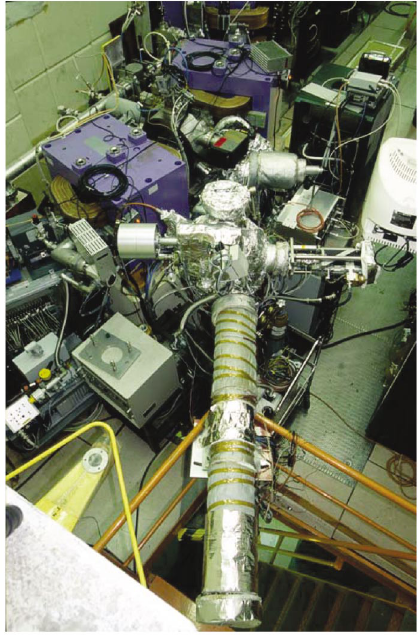
FIG. 1. (Color) Picture of the CERN ion-induced desorption experiment in LINAC 3. The 1.4 m long test vacuum chamber is visible in the